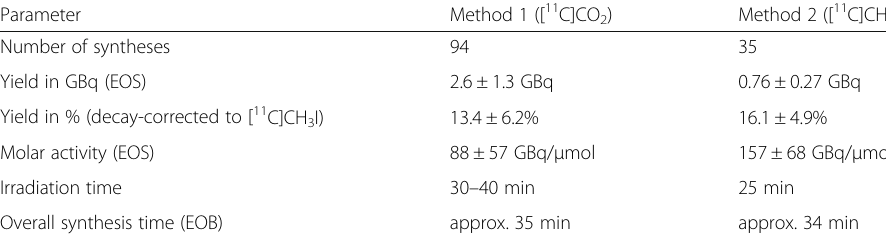
Table 1 Comparison of the productions starting from either [ 11 C]CO 2 or [ 11 C]CH 4 Parameter